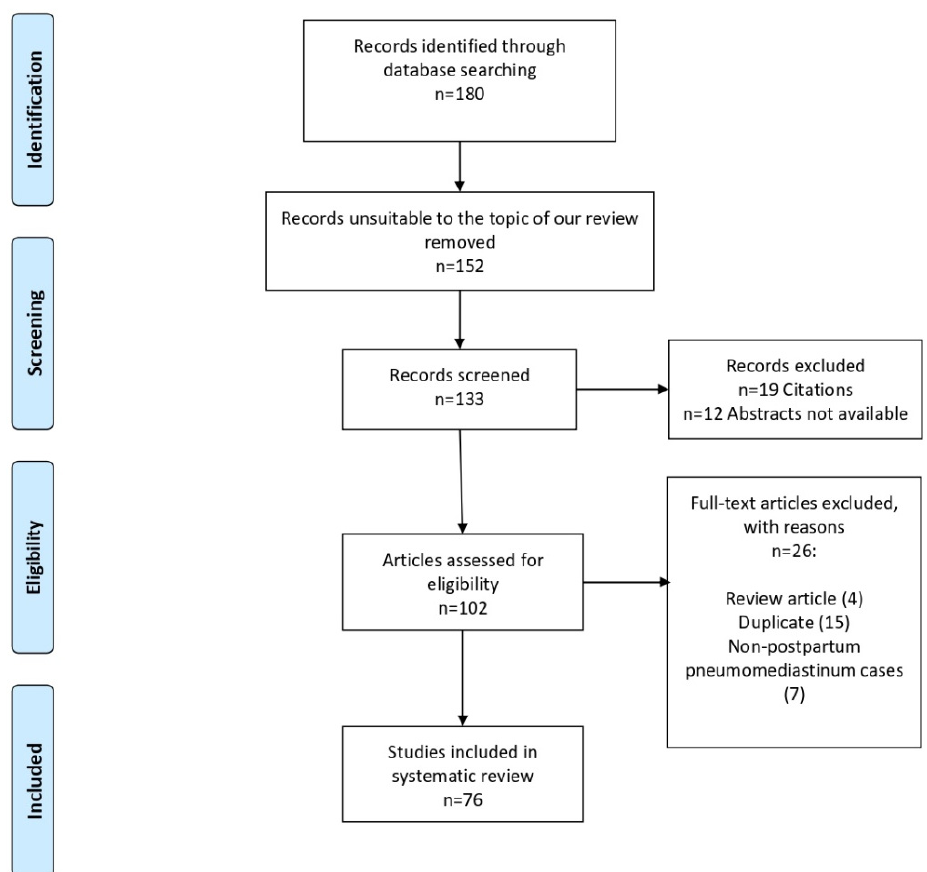
Figure 1. Flow diagram of the study.